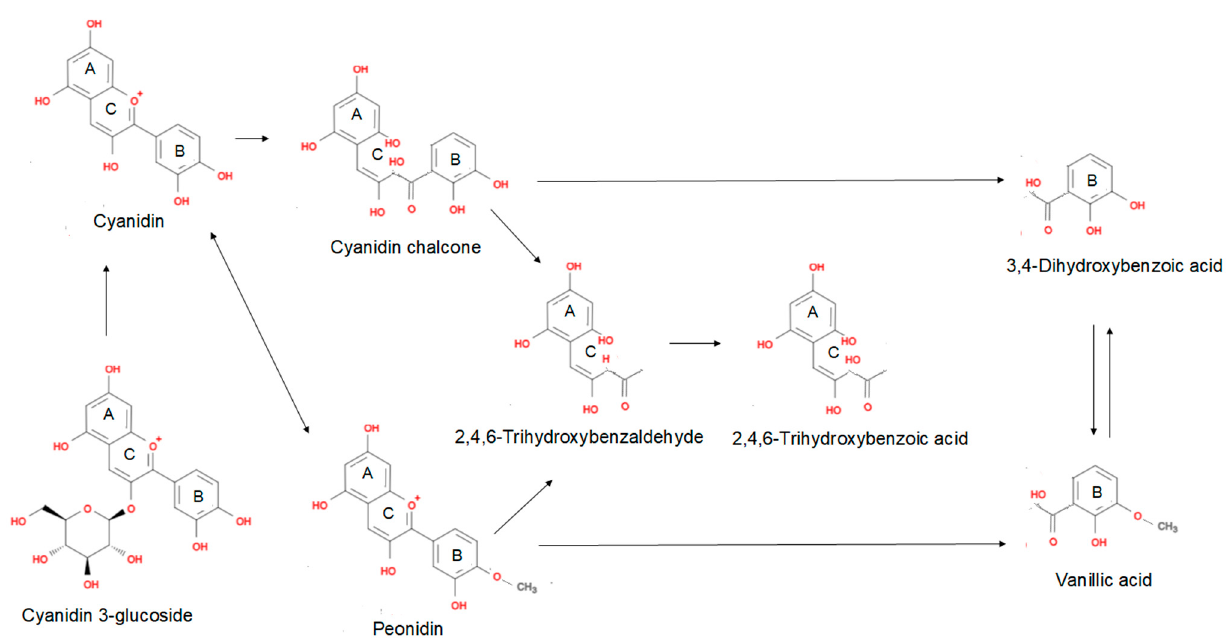
Figure 4. Anthocyanin metabolism by the intestinal microbiota and the formation of different acids. Based on [124,138,139]. The figure was modified from Mind the Graph (https://mindthegraph.com (accessed on 11 February 2022)).